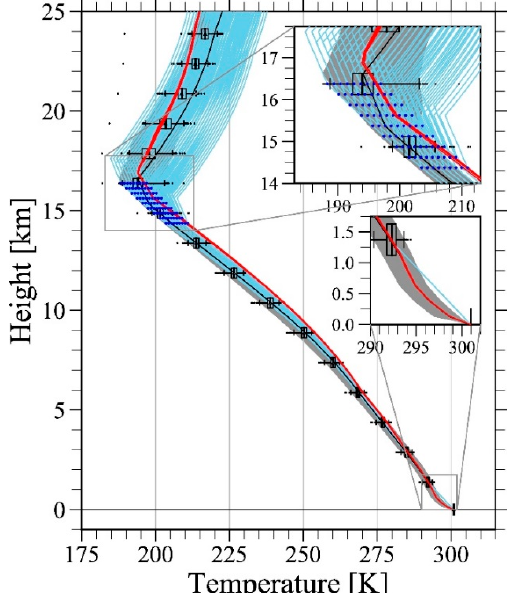
Figure 2. The vertical profiles of temperature used as the initial conditions for the numerical experiments as well as some references. The black and sky-blue lines show the temperature profiles used in CTL and sensitivity experiments, respectively. The blue dots indicate the tropopause temperatures. The red line indicates the vertical profile used in the pseudo-global warming experiments of Kanada et al. [18]. Gray shade means the range of the 1st and 99th percentiles of the temperatures at each level obtained from the JRA-55 data analysis. The whisker-and-box plot also indicates the range obtained from the JRA-55 data, the width of the box shows the 25th and 75th percentiles, and the vertical line in each box indicates the median value. The profiles of the PGW condition (red line) and the observations (gray shade) are adjusted so that the temperature at the lowest level is the same as that of CTL. Table 2. The values of the environmental parameters. Indicated are the values in the CTL and sensitivity experiments, obtained from the JRA-55 analysis, and in the pseudo-global warming (PGW) experiment of Kanada et al. [18]. For the sensitivity experiments, the minimum and maximum values are indicated.